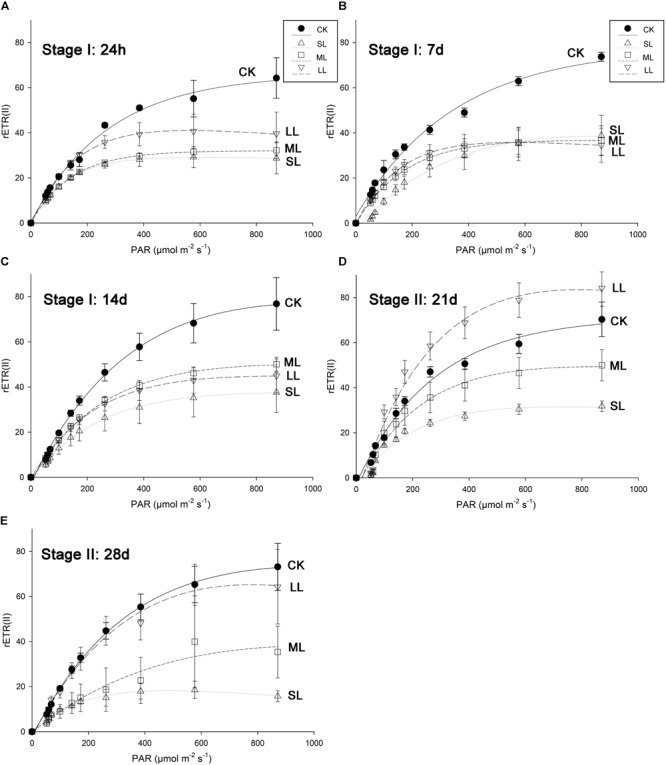
Mean relative electron transport rate (rETR) of rapid light response curves (RLCs) in U. prolifera of CK, SL, ML, and LL at (A) 24 h, (B) 7 days, (C) 14 days, (D) 21 days, and (E) 28 days. All experiments were performed in triplicate. The data are the mean of three independent experiments (±SD).